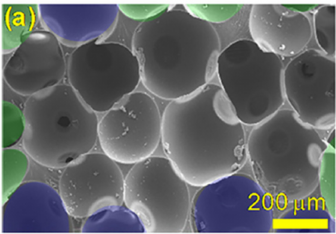
Figure 1. The micromorphology of a PU sample. Reprinted with permission from [18]. Copyright 2020,